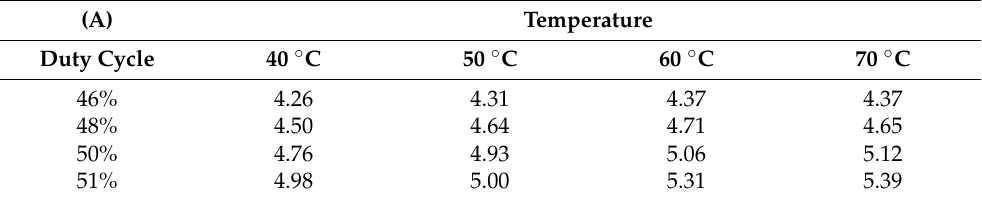
Figure 6. Oscilloscope plots of the current flowing through the inductor (blue), output voltage (cyan), and gate voltage (green) for increasing duty cycle ratio and temperature at a switching frequency of 30 kHz. Table 2. Inductor current peak (in A) for different duty cycles and temperatures.